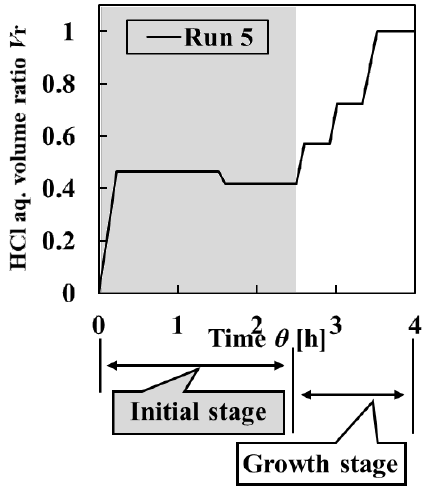
Figure 10. Change in HCl aq. volume ratio V r against the crystallization time in Run 5.